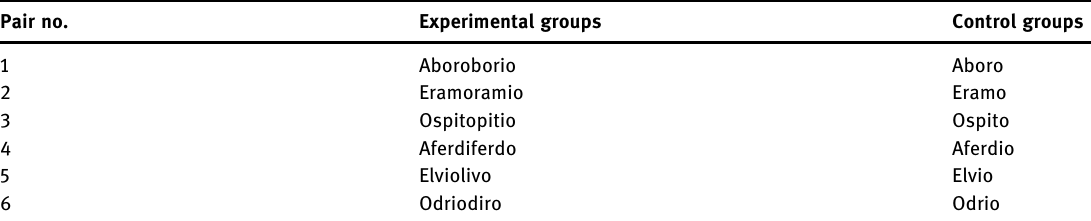
Table 6: Stimuli in the “ Long Wds ” condition Pair no.